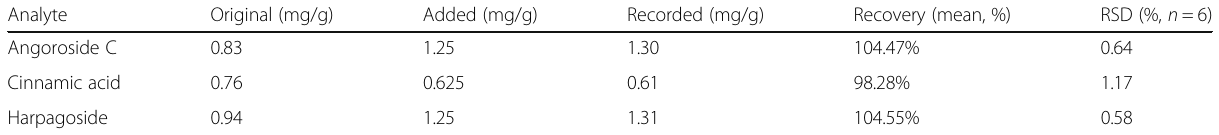
Table 2 Reproducibility and recovery of angoroside C, cinnamic acid and harpagoside Analyte